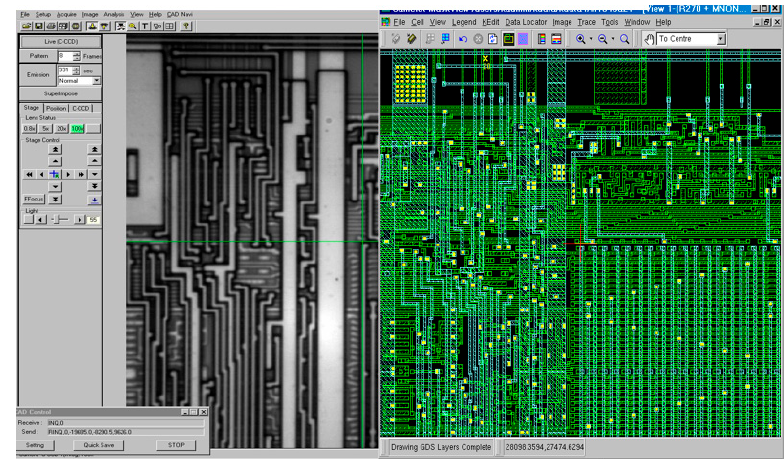
Figure 27. Syncing FIB image with layout for PFA process.